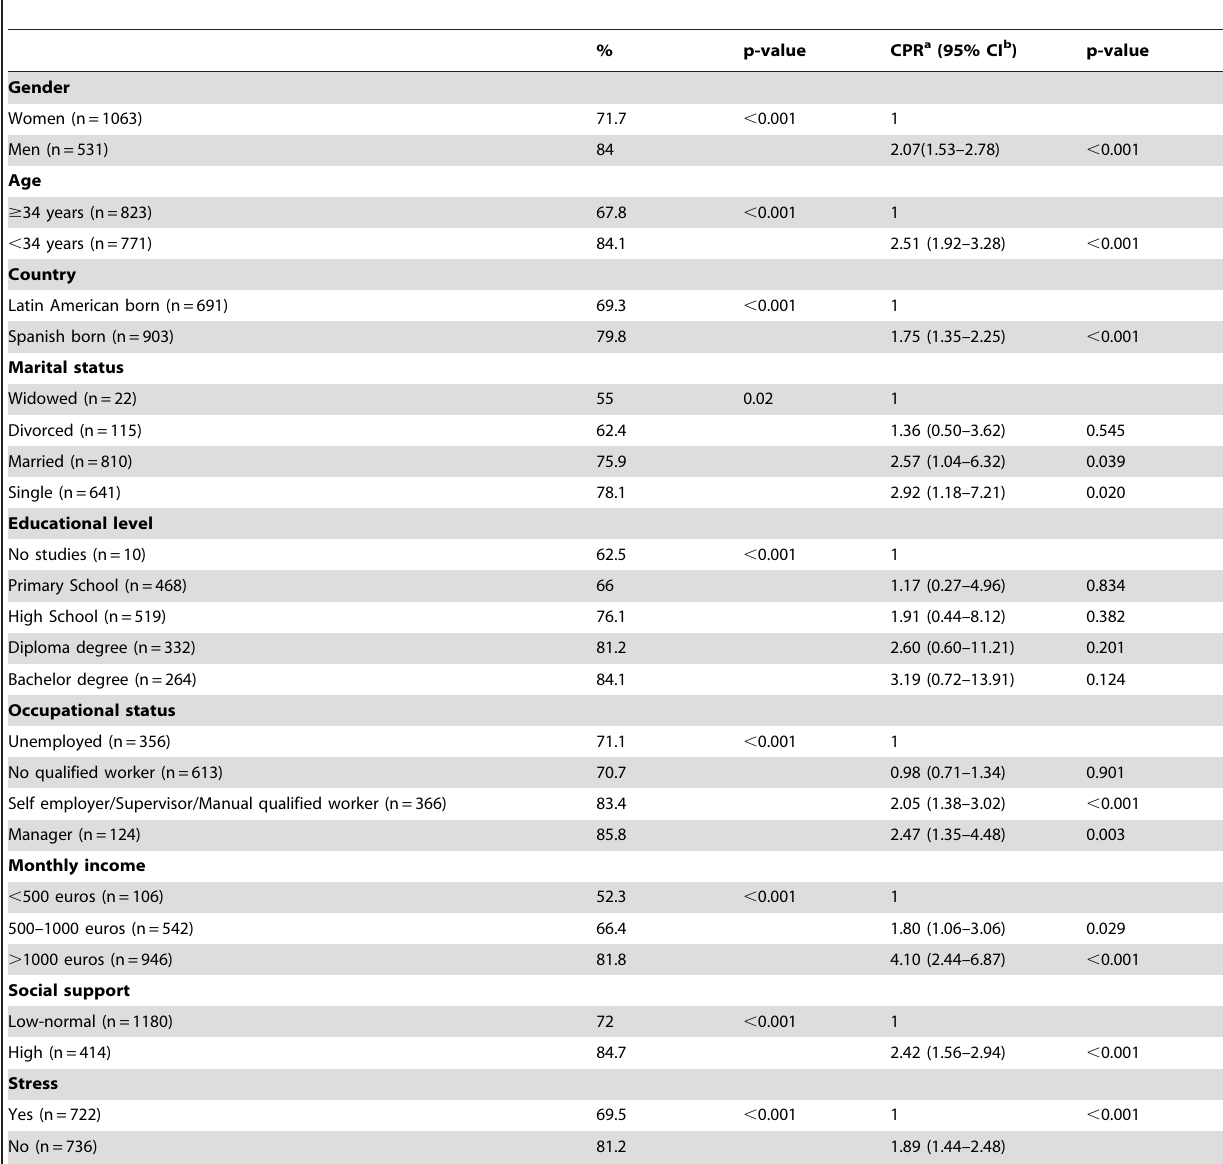
Table 3. Distribution of good/very good/excellent self-reported health status (%) with the crude prevalence ratio, stratified by sociodemographic characteristics, social support and